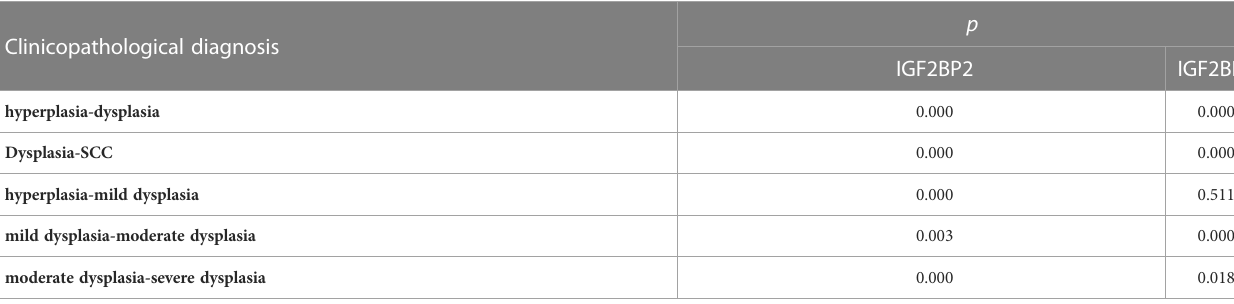
TABLE 3 Differential expression of IGF2BP2 and IGF2BP3 in epithelial hyperplasia, dysplasia and SCC*.